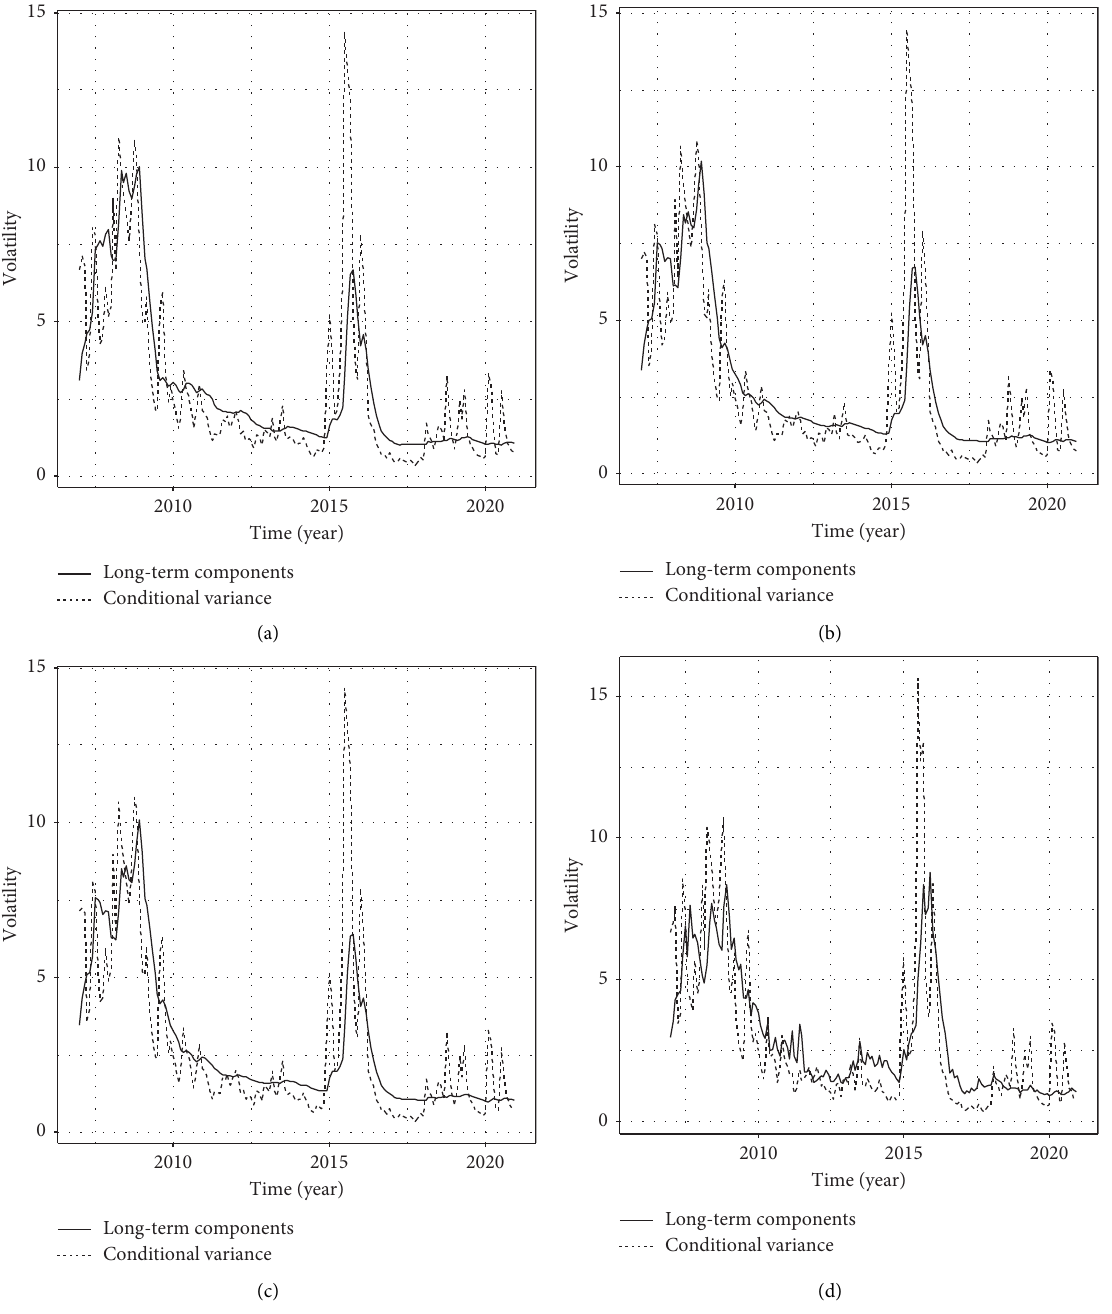
Figure 1: Fitting of conditional variance and long-run components of volatility for the multifactor GARCH-MIDAS model incorporating macroeconomic variables and CEPU. (a) rAVGRV+IVA. (b) rAVGRV+M2. (c) rAVGRV+DFI. (d)